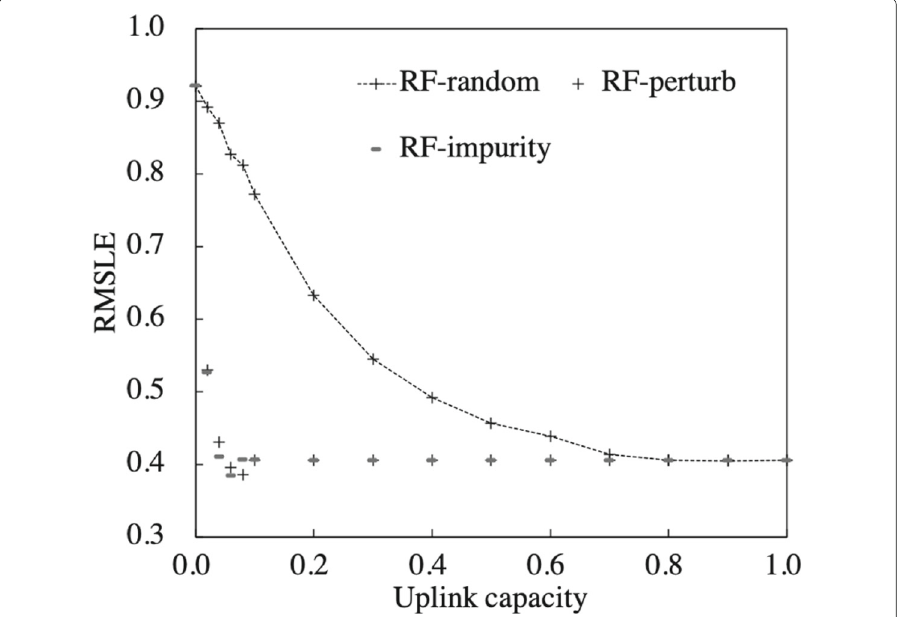
Fig. 6 Prediction accuracy (RMSLE) vs. uplink capacity obtained using RF machine learning method for prediction. Perturb or impurity method was used for feature